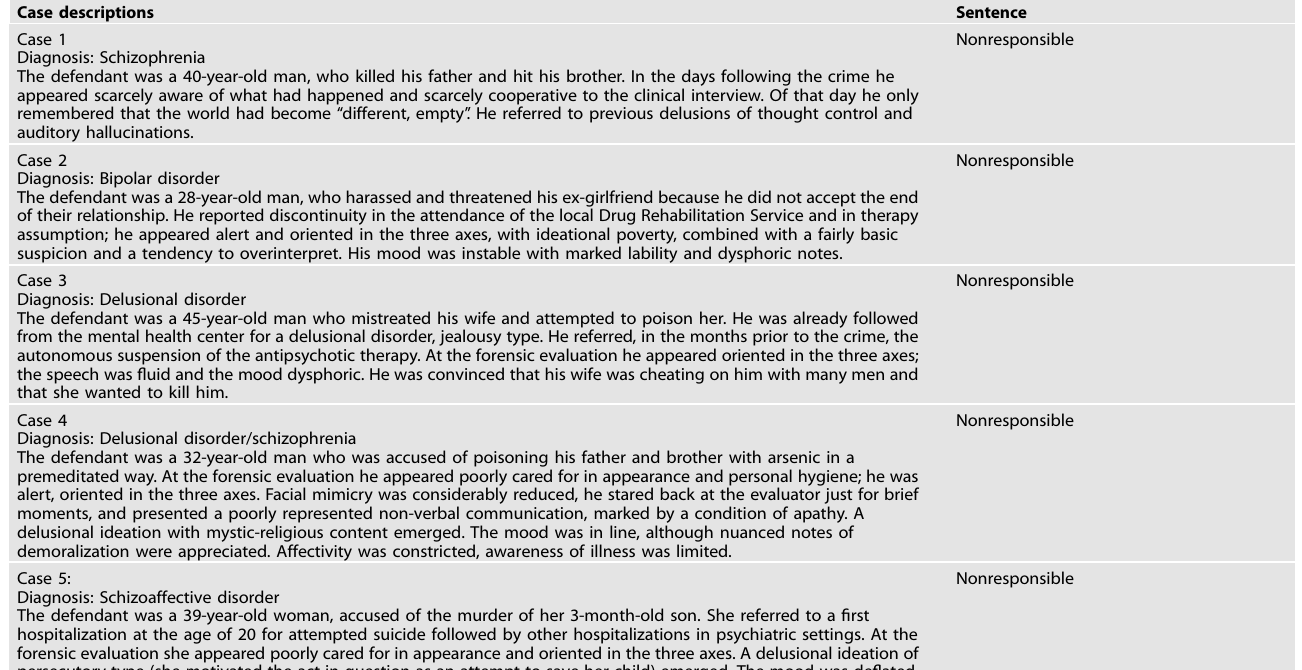
Table 2. Hypothetical forensic cases